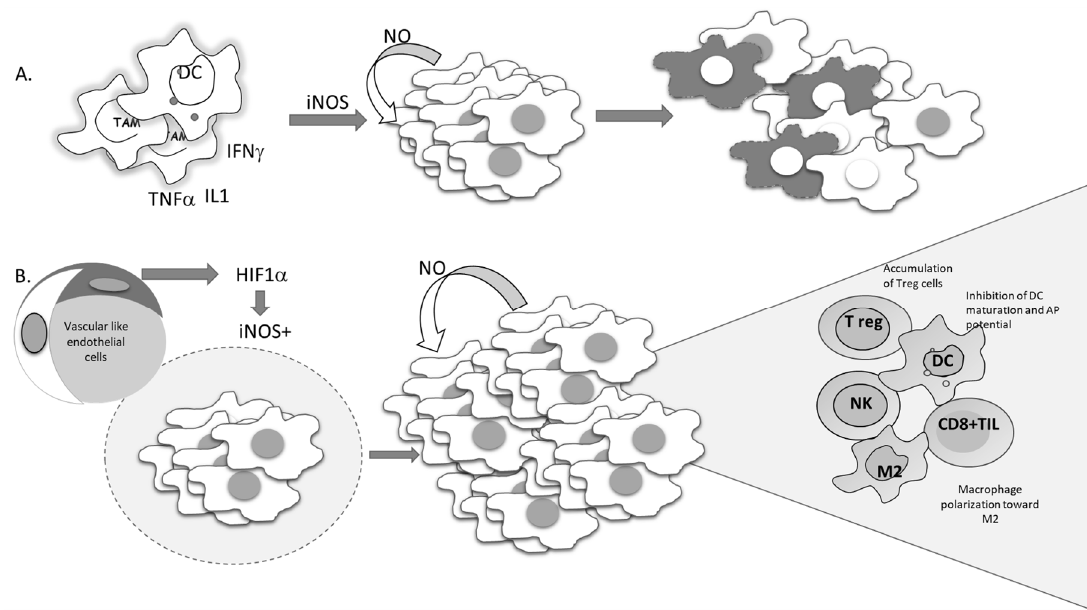
Figure 7. Conflicting outcomes of iNOS-produced NO in tumor cells. ( A ) Proinflammatory cytokines trigger the expression of iNOS in tumor cells, promoting NO-mediated cell suicidal activities. ( B ) Hypoxia-driven expression of iNOS-mediated tumor cell proliferation and re-education of the immune cells in the tumor microenvironment.